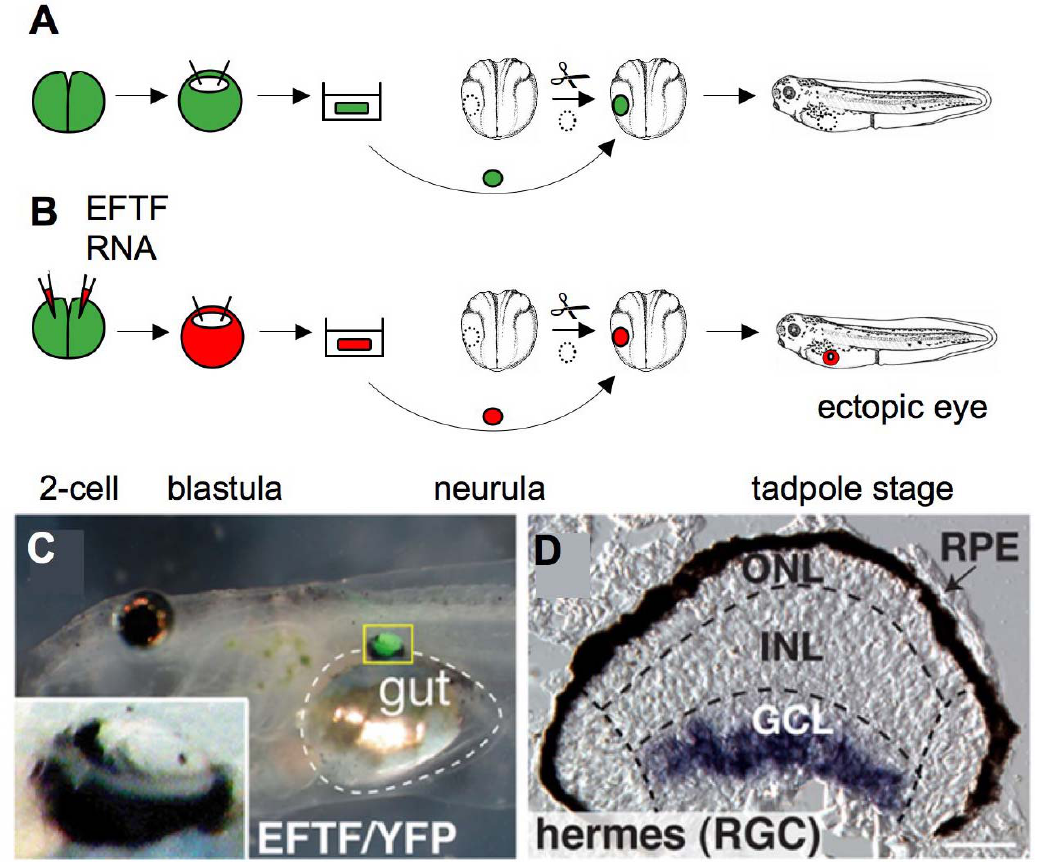
Figure 3. In vitro induction of functional eyes from ACC. ( A ) ACC were dissected from blastula stage transgenic embryos constitutively expressing yellow fluorescent protein (YFP). When transplanted into the flanks of neurula stage embryos, these ACC developed into sheets of epidermis; ( B ) In contrast, ACC injected with mRNA coding for a set of seven different transcription factors, collectively called the eye field transcription factors (EFTF), generated ectopic eyes after transplantation; ( C ) Tadpole embryo with ectopic EFTF/YFP-expressing eye in close proximity to the gut (indicated by dashed lines). Inlay shows a magnification of the ectopic eye; ( D ) In situ hybridization showing the expression of the retinal ganglion cell (RGC) marker, hermes, in a section of the ectopic eye. Outer nuclear (ONL), inner nuclear (INL) and ganglion cell layers (GCL) are indicated; RPE, retinal pigment epithelium; ( E ) Half of an animal cap from an uninjected transgenic embryo is not sufficient to generate an eye, if it is used to replace portions of the eye field; ( F ) In contrast, half of an animal cap expressing EFTF is able to replace the eye field and generate a functional eye. Control ACC expressing YFP only form epidermis ( G ), while EFTF-expressing ACC generate an eye ( H ); Insert in (H) shows a higher magnification of the eye. Sections of the control ( I ) and induced eye ( J ) of the same tadpole embryo. YFP fluorescence indicates that the eye originates from donor tissue. Figures (C,D and G–J) were reproduced from a PLoS Biology article by Viczian et al. [42]. Scale bar: (D) 12